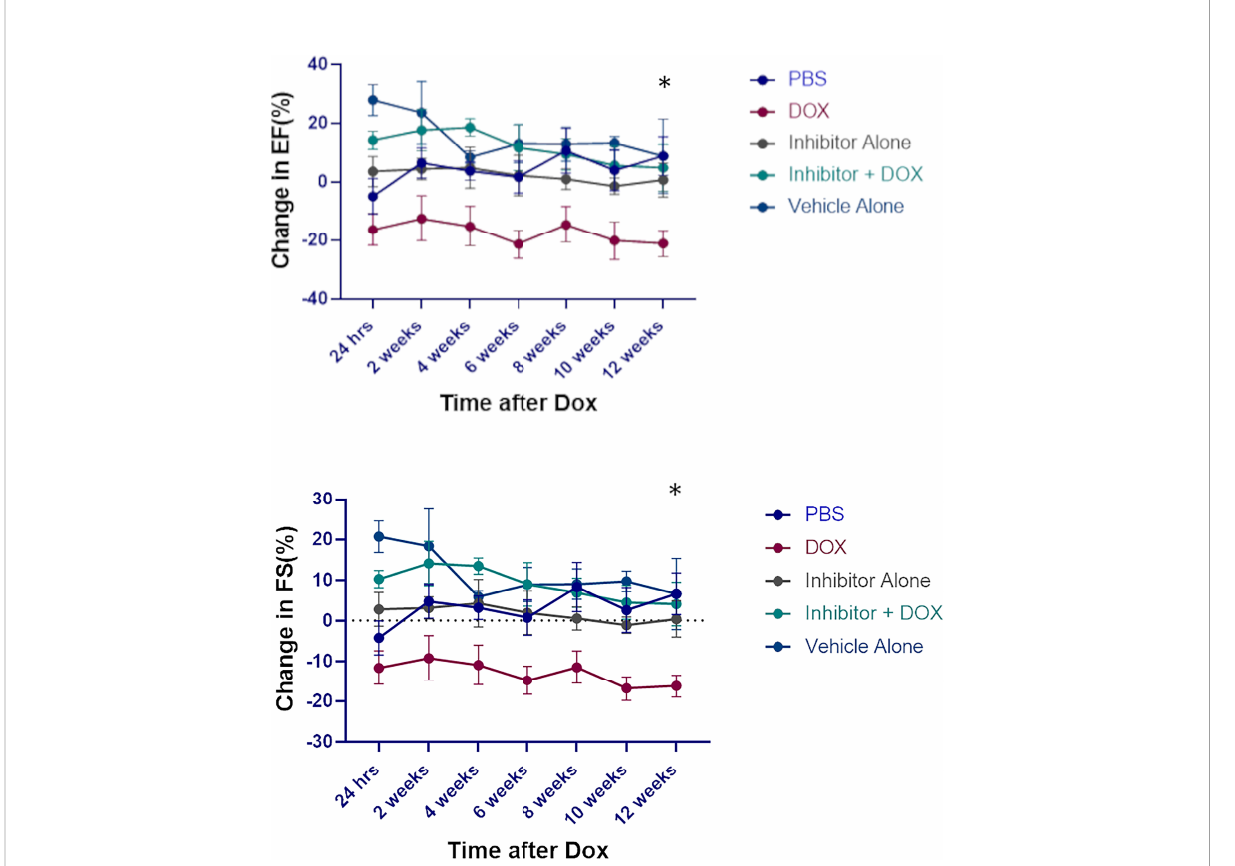
FIGURE 7 Effect of neutrophil elastase (NE) inhibitor on heart tissue following doxorubicin (DOX) treatment. Ejection fraction (EF) and fractional shortening (FS) were quanti fi ed by echocardiography up to 12 weeks after therapy. Data are presented as mean ± SEM, n = 5 each, * p < 0.05, one-way ANOVA analysis with Tukey comparison was used to compare the